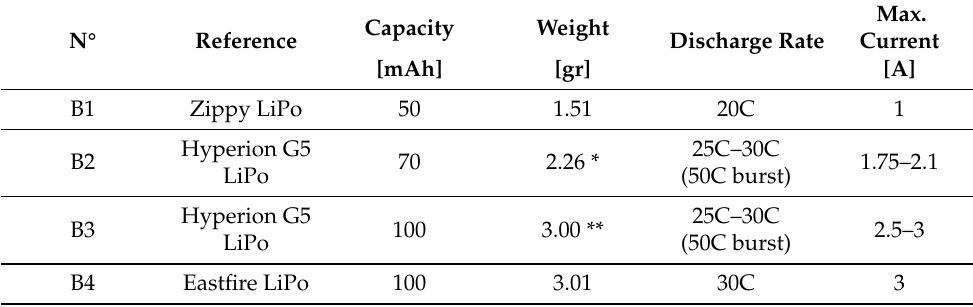
Table 2. Characteristics of the batteries.